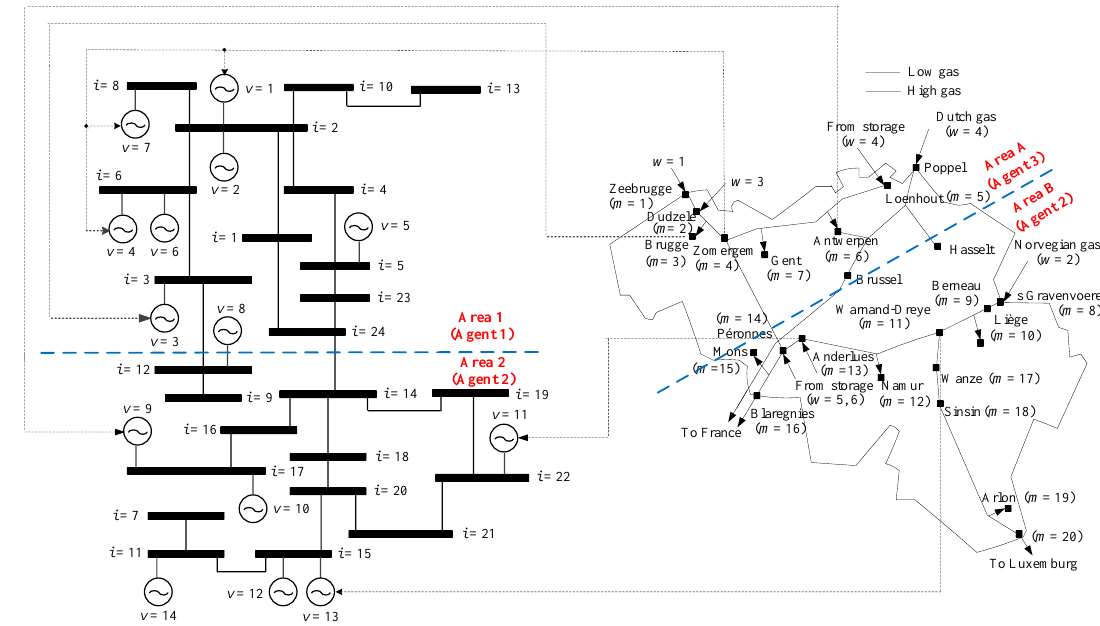
Figure 5. Case study 2: Belgian 24-node power system and 20-node gas system.